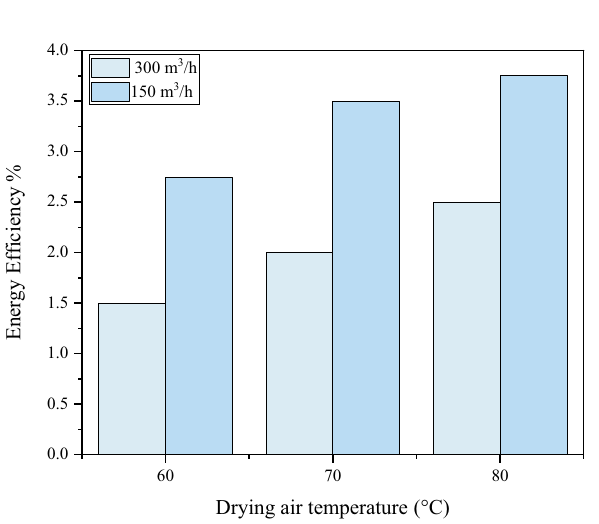
Figure 13. Energy efficiency for drying of fig slices at different drying air temperatures and flow